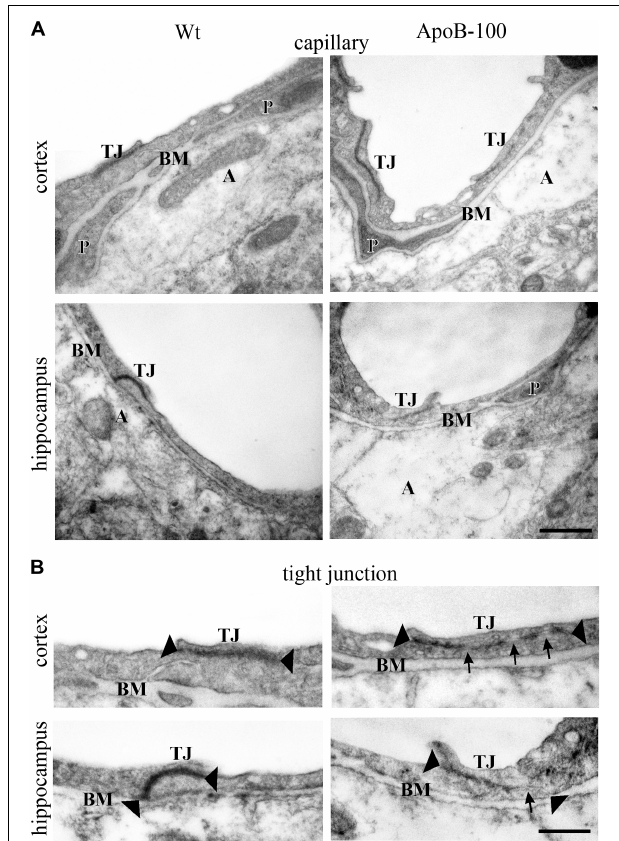
FIGURE 5 | Electron micrographs of brain capillaries (A) and tight junctions (B) in the frontal cortex and hippocampus of wild-type (Wt) and APOB-100 transgenic (APOB-100) mice. Tight junctions in (B) are larger magnifications of tight junctions seen in (A) . A, astrocyte; BM, basal membrane; P, pericyte; TJ, tight junction. Scale bars: 500 nm (A) and 800 nm (B) .